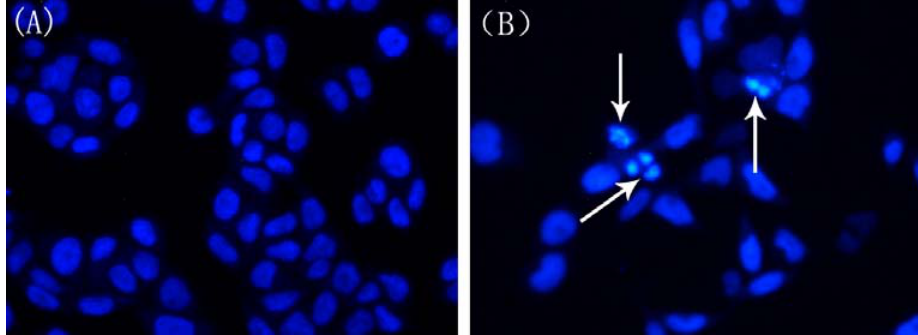
Figure 4. Morphological observation of SMMC-7721 cells treated with SFE-CO for 48 h by fluorescence microscopy. Cells undergoing apoptosis and nuclear fragmentation are indicated by arrows. ( A ) Untreated control cells; ( B ) treatment with 200 μ g/mL extract. The representative images of only 2 pictures independent experiments SFE-CO 2 are shown. Magnification: